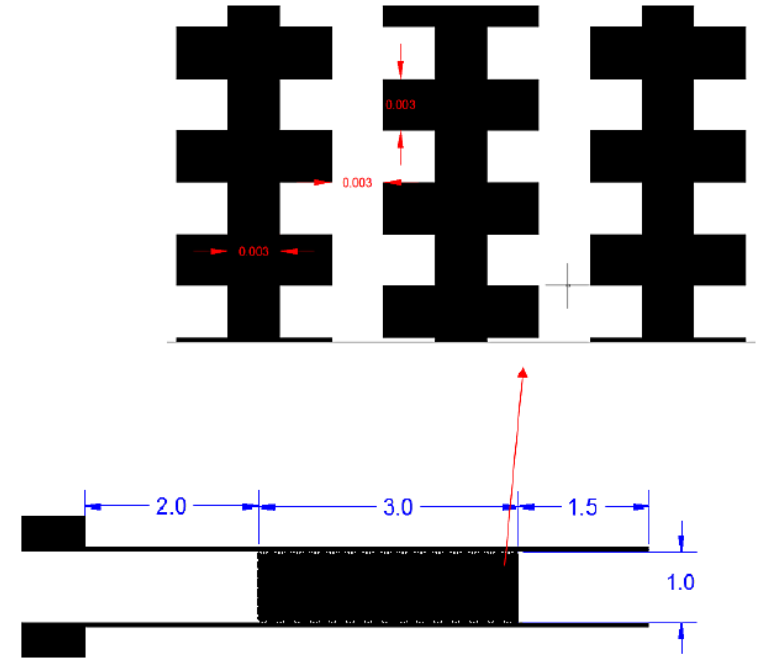
Figure 1. Interdigitated castellated microelectrode mask design with width and length of 1cm and nearly 3cm